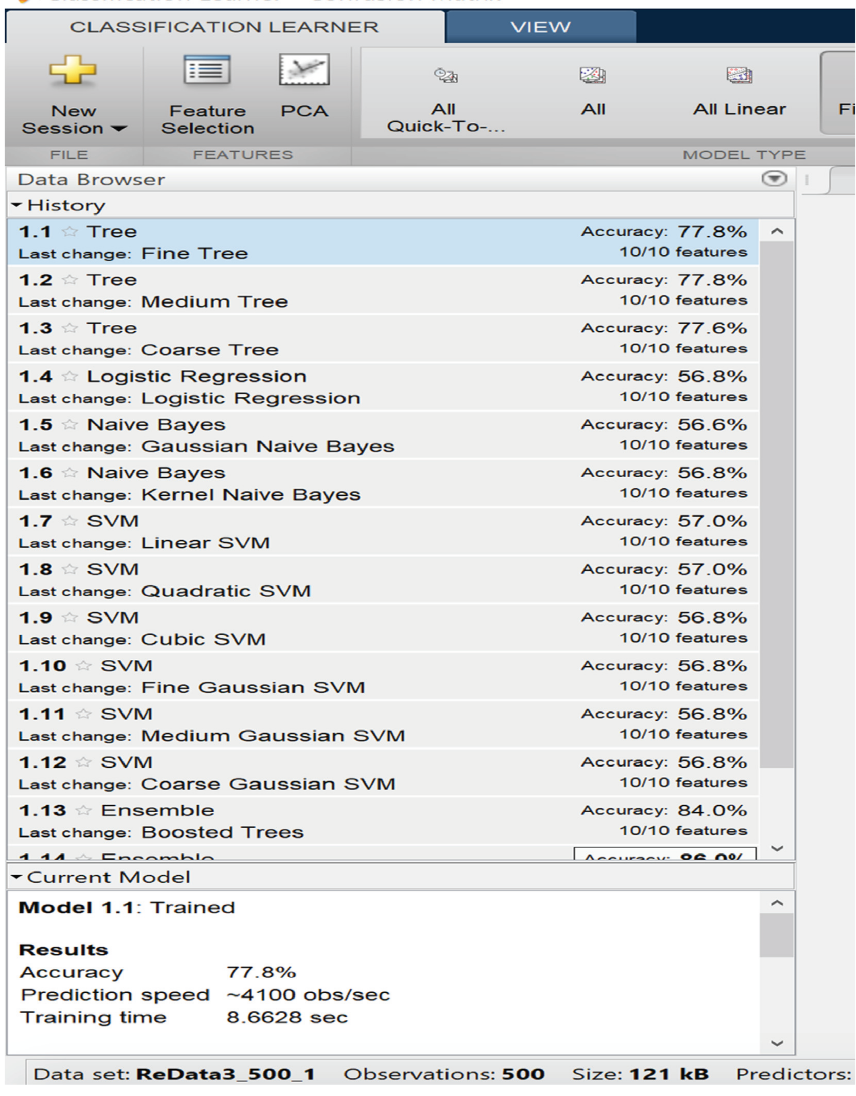
Figure 18: Algorithmic runs on 500-claim